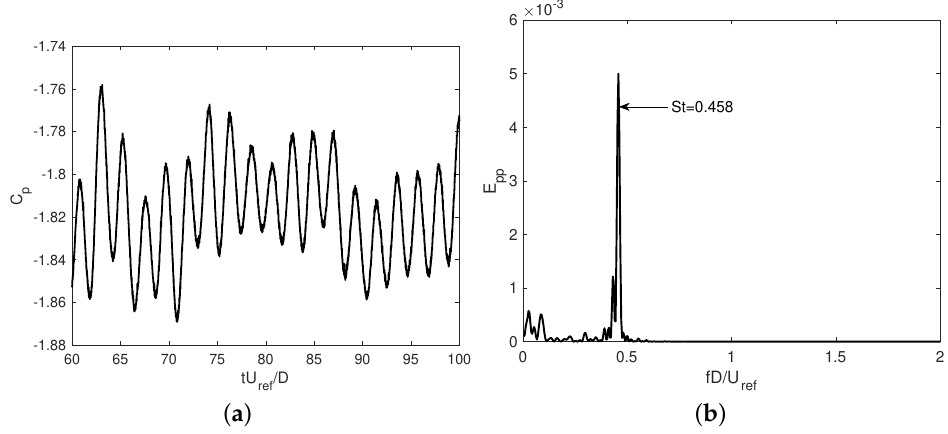
Figure 14. ( a ) Reference signal used as periodic oscillator. ( b ) Power spectrum of the reference oscillator